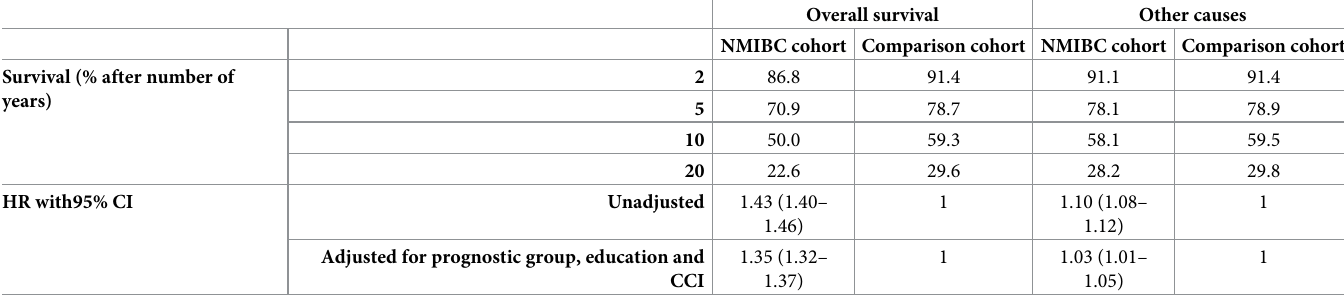
Overall survival Other causes NMIBC cohort Comparison cohort NMIBC cohort Comparison cohort 2